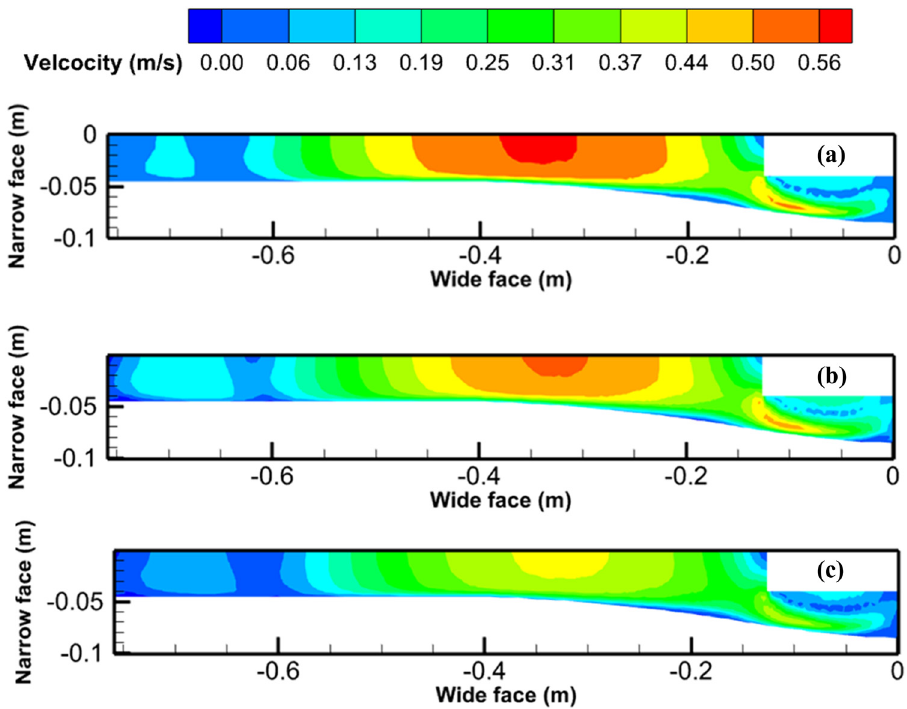
Figure 9: Surface velocity of di ff erent submerged depths at 6 m · min − 1 casting speed: ( a ) 130 mm, ( b ) 160 mm, and ( c ) 190 mm.